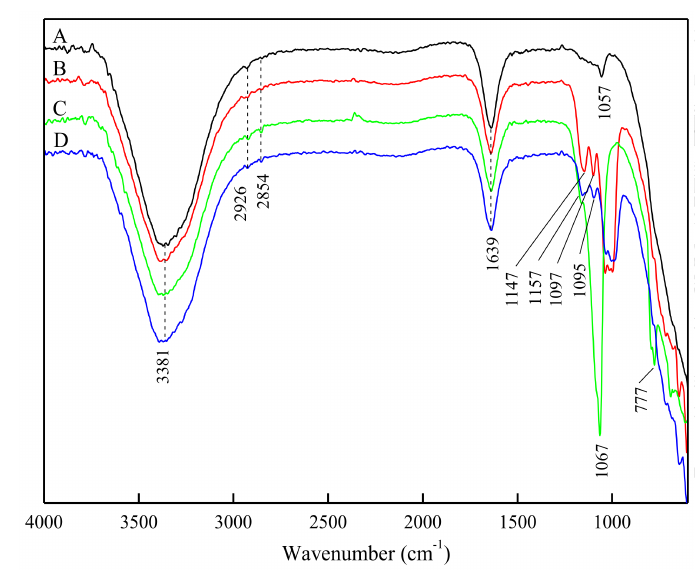
Figure 7. ATR-FTIR spectra of feldspar and quartz with DDA (5 × 10 − 4 M) at pH 2: (A) quartz and DDA, (B) feldspar and DDA, (C) pretreated quartz and DDA, and (D) pretreated feldspar and DDA.